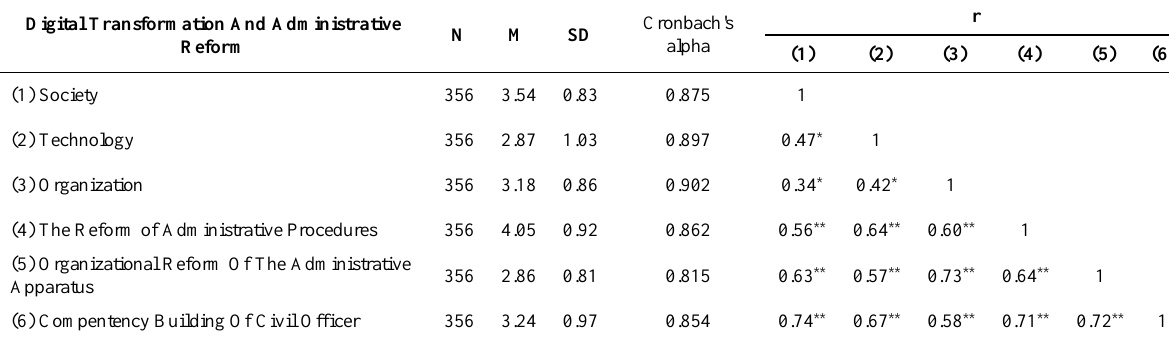
Table 3. Digital transformation and administrative